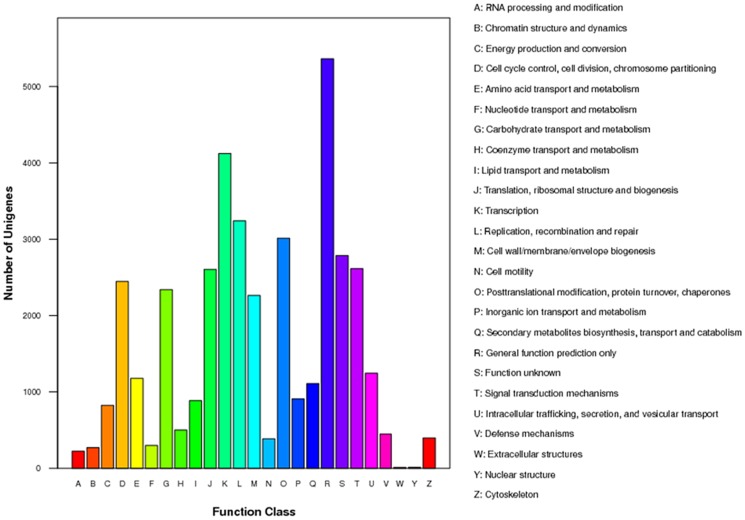
Clusters of orthologous groups (COG) classification.